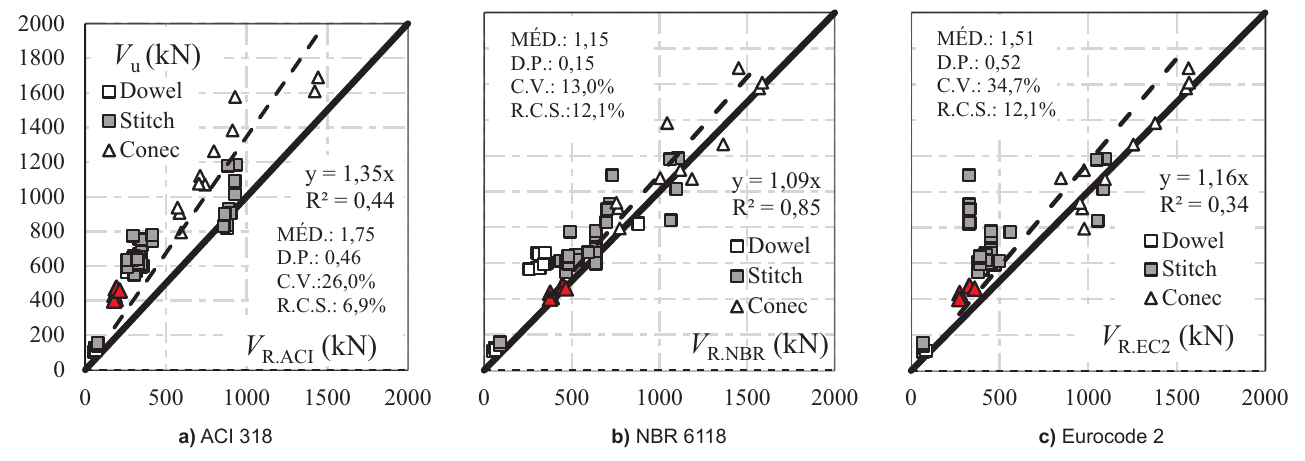
Precisão das adaptações propostas para a verificação da resistência de lajes reforçadas com conectores de aço e PRFC